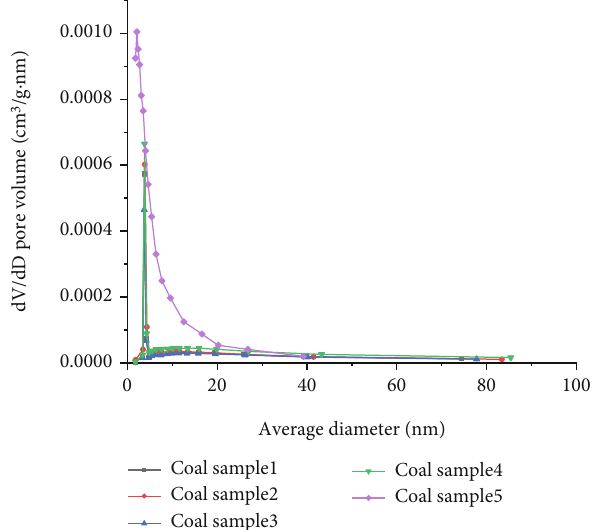
Figure 8: Distribution characteristics of pore diameter of a coal